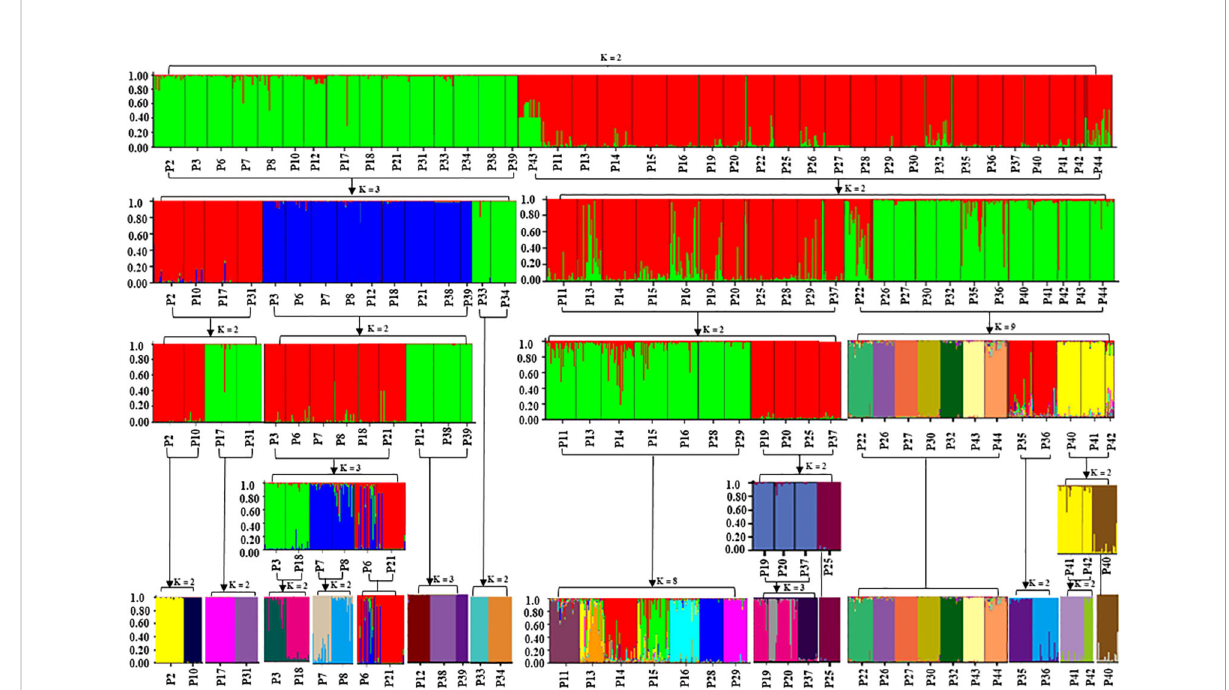
FIGURE 2 Progress of fi ve hierarchical levels analysis of 905 individuals from 38 populations of Wikstroemia monnula using STRUCTURE based on twelve microsatellite loci. The optimal K based on the delta K ( D K) methods for every hierarchical analysis was shown. All structure analysis were marked by black arrows, the populations for each analysis were labeled using bracket, and the K value indicated the optimal K for each analysis. The color of the STRUCTURE plot in the fourth and fi fth hierarchy has been adjusted to avoid confusion of different genetic